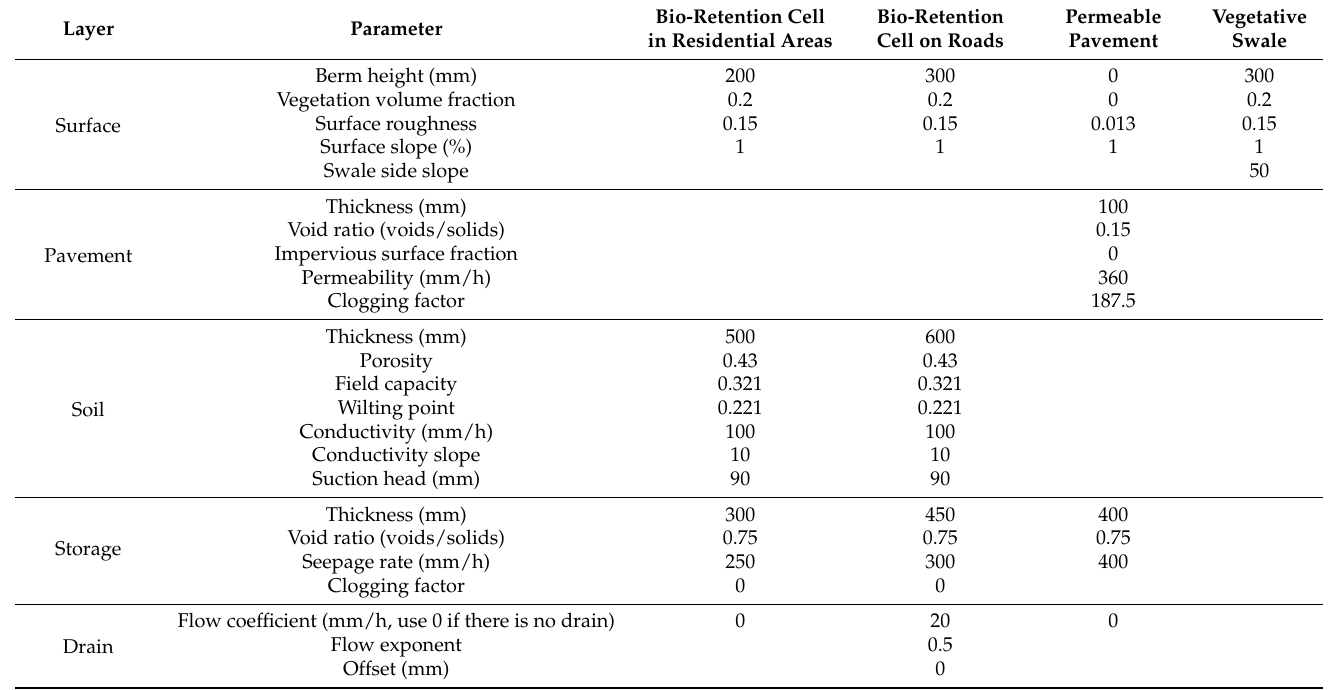
Table 3. Parameters of LID